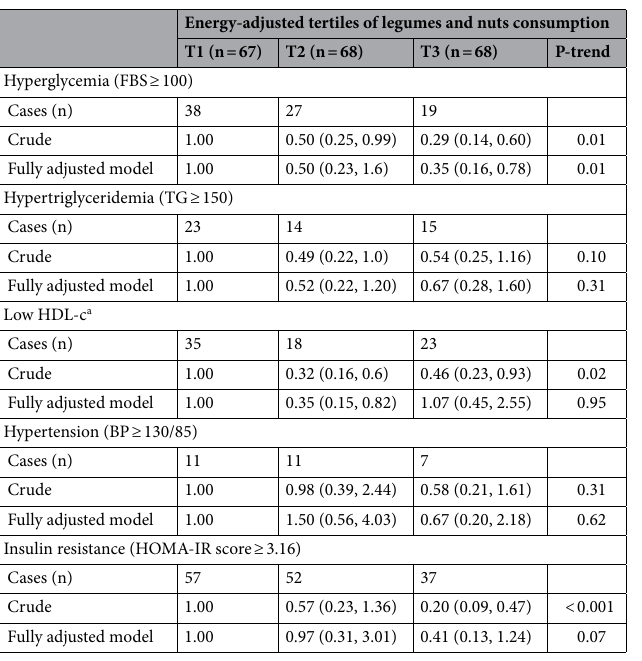
Table 4. Multivariate adjusted odds ratio (OR) and 95% confidence interval (CI) for MUO components across energy-adjusted tertiles of legumes and nuts consumption. All values are odds ratios and 95% confidence intervals. Fully adjusted model: adjusted for age, sex, energy intake, physical activity, socioeconomic status (parental education, parental job, number of family members, having car in the family, having computer/ laptop, having personal room and having trip) and body mass index (BMI). a HDL-c < 40 mg/dL for the age of < 16 years, and < 50 mg/dL in girls/ < 40 mg/dL in boys for the age of ≥ 16